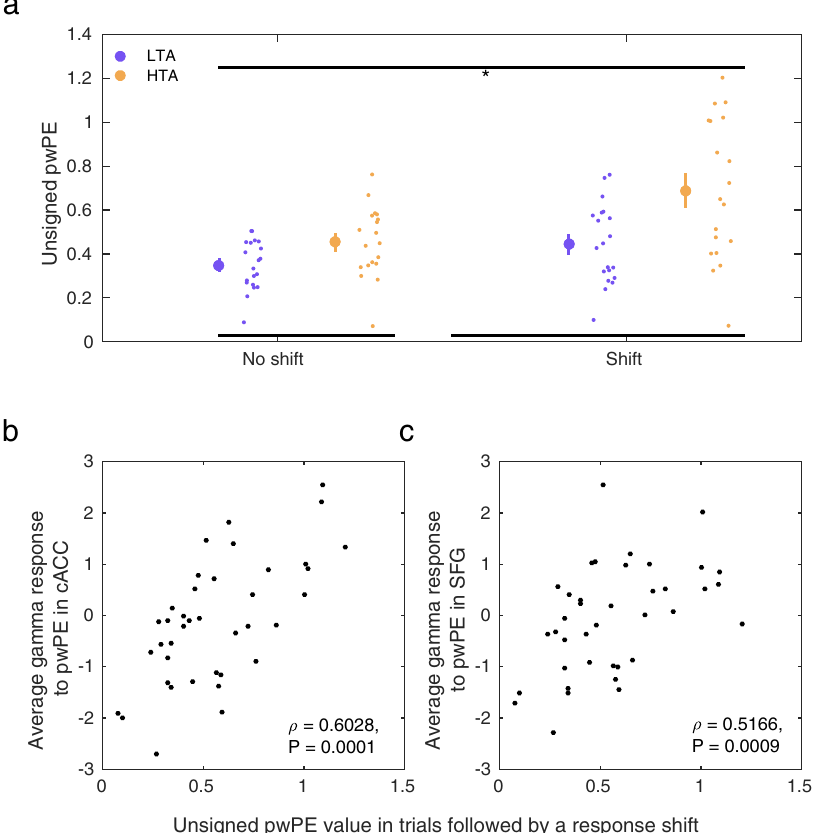
Fig. 4 Trials leading to a shift in response choice are associated with larger unsigned pwPE values. a The values of unsigned pwPE updating beliefs about stimulus-reward contingencies (denoted by | ε 2 |) were larger in trials that were followed by a response shift (signi fi cant main effect of factor Shift, 2 × 2 synchronised rearrangements, P = 0.0012; denoted by the black line on top and the asterisk). High relative to low trait anxiety individuals also had larger | ε 2 | overall (main effect of Group, P = 0.0068; denoted by the black lines at the bottom) and a more pronounced dissociation between the | ε 2 | values in trials followed by a response shift or repetition (signi fi cant interaction, P = 0.0200). Data in each group are represented using the average (large dot) with SEM bars. To the right are individual data points to display dispersion. HTA, high trait anxiety (yellow; N = 19 participants); LTA, low trait anxiety (purple; N = 20 participants). b Non-parametric correlation between the average gamma response to the unsigned pwPE regressor in the cACC and the | ε ρ = 0.6028, P = 0.0001; the gamma average was estimated in the signi fi cant cluster of between- 2 | values in trials followed by a response shift (Spearman group differences, Fig. 3). c Same as ( b ) but for the dmPFC ( ρ = 0.5166, P =